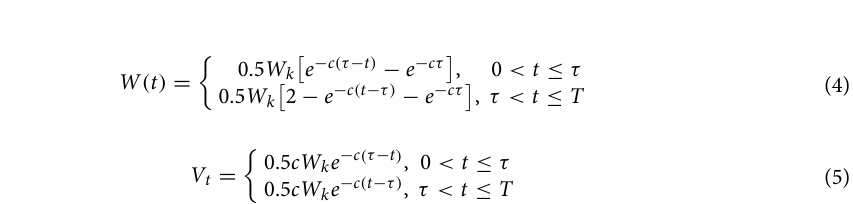
Figure 2. Piecewise Knothe time function graphic with c at different values (P1, P2 are inflection points of the two